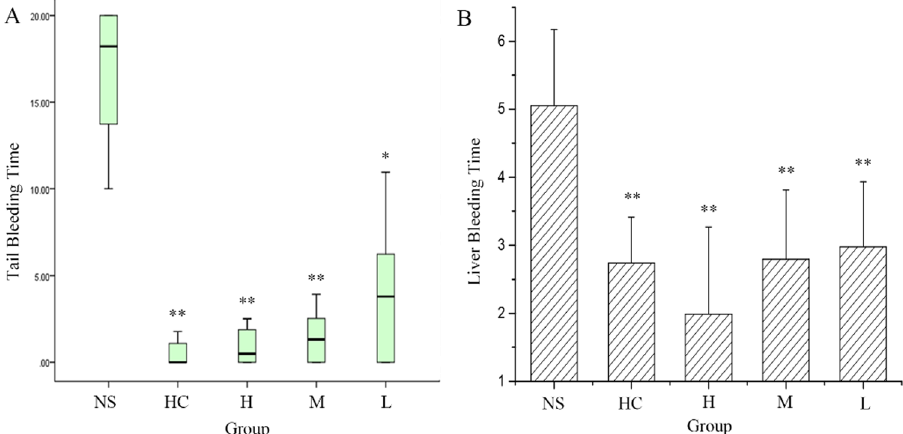
Figure 4. ( A ) Haemostatic effect of egg yolk oil carbon quantum dots (EYO CDs) in mouse tail transection model. ( B ) Haemostatic effect of EYO CDs evaluated by liver laceration bleeding model. The male Kunming mice were divided into normal group (treated with saline, NS), positive drug group (treated with haemocoagulase, HC), high-dose EYO CDs, medium-dose EYO CDs, and low-dose EYO CDs. (n = 9 per